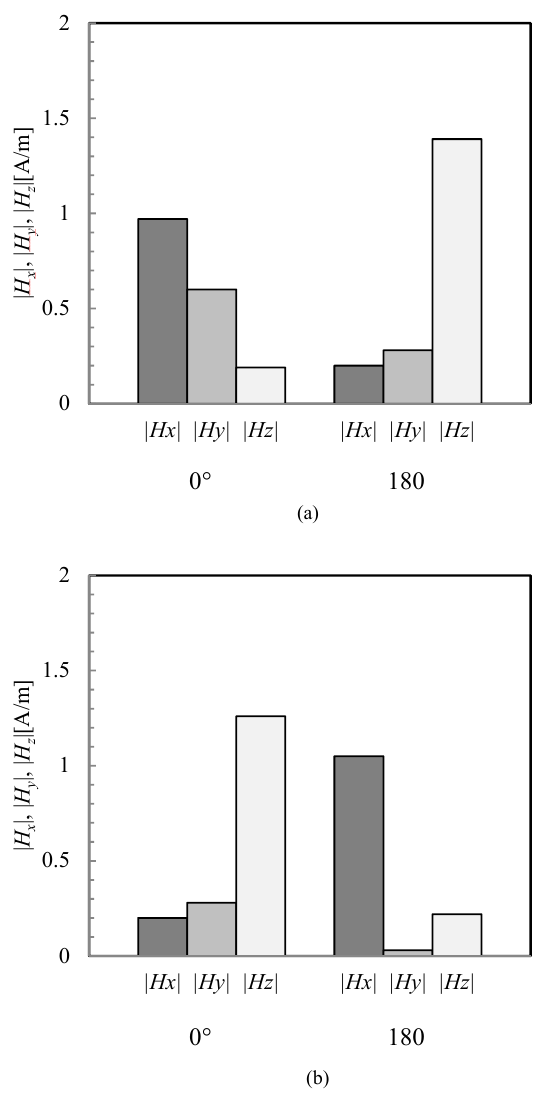
Figure 7. Values of | H x | , | H y | , and | H z | in the analysis area for parking configurations ( a ) 1 and ( b ) 2.